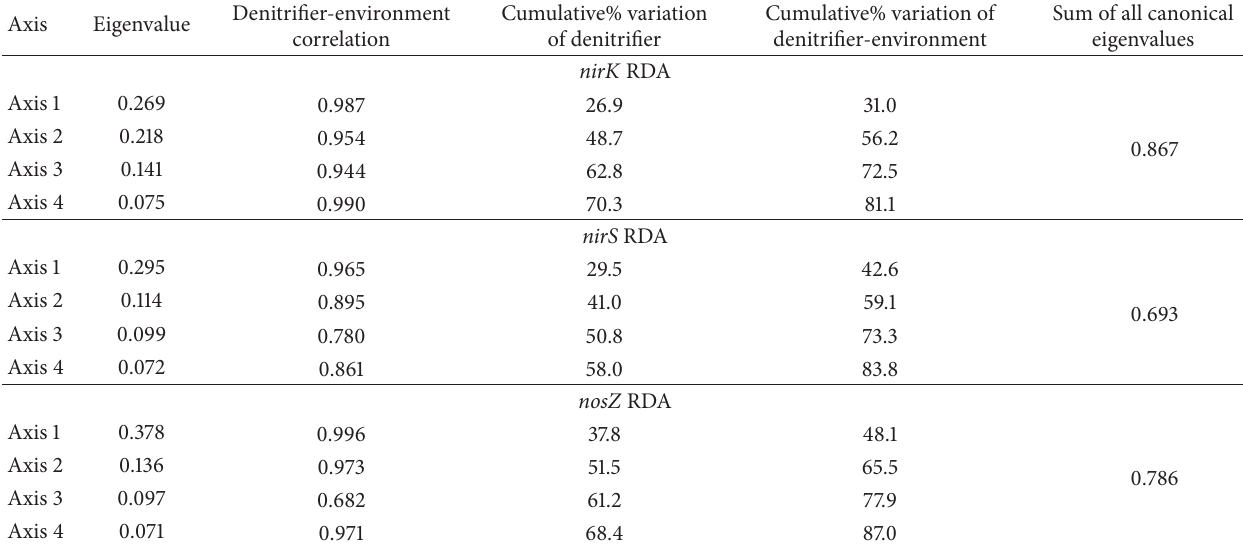
Table 4: Redundancy analysis results of nirK , nirS , and nosZ DGGE profiles.